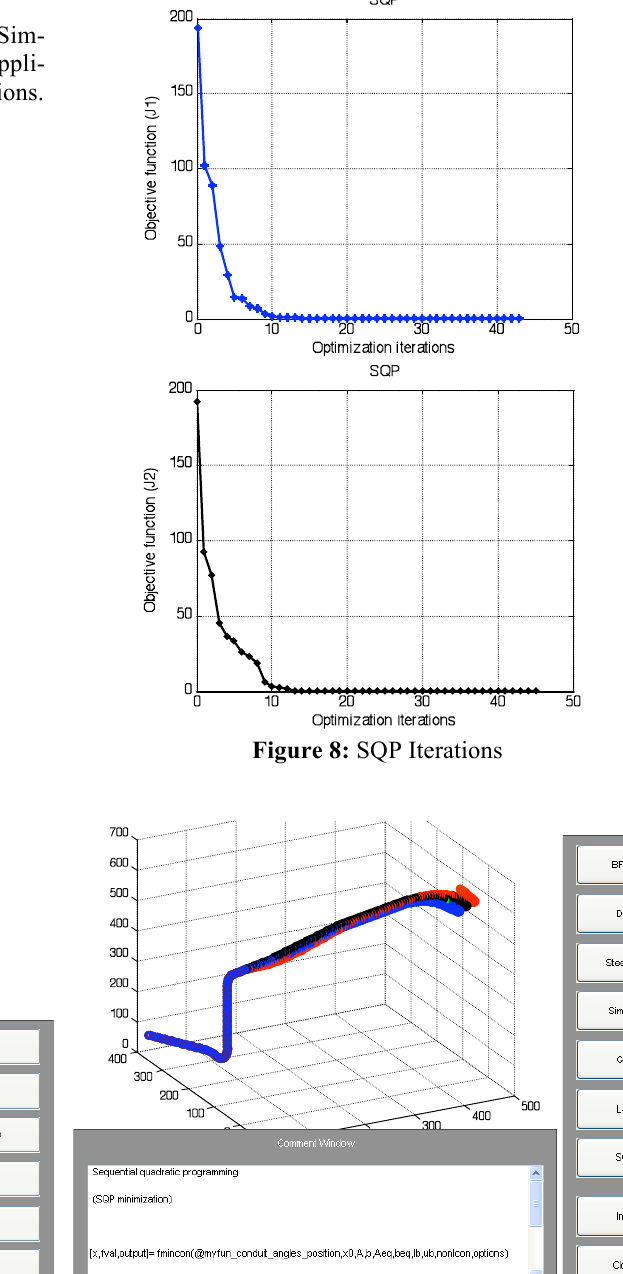
Fig. 9. SQP module on the MATLAB